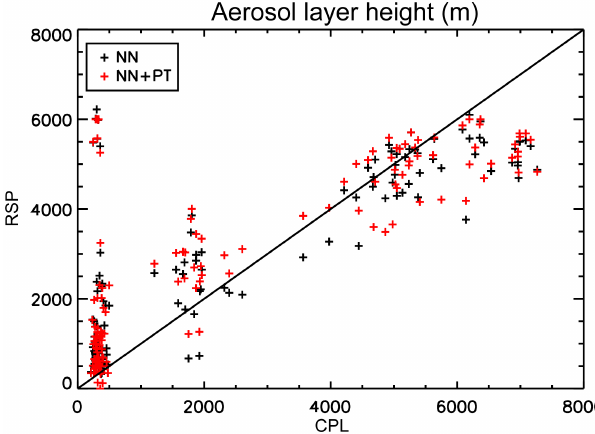
Figure 15. RSP versus CPL aerosol layer height. Black crosses: neural network retrievals. Red crosses: Phillips–Tikhonov with neu- ral network first guess. Statistics shown in Table